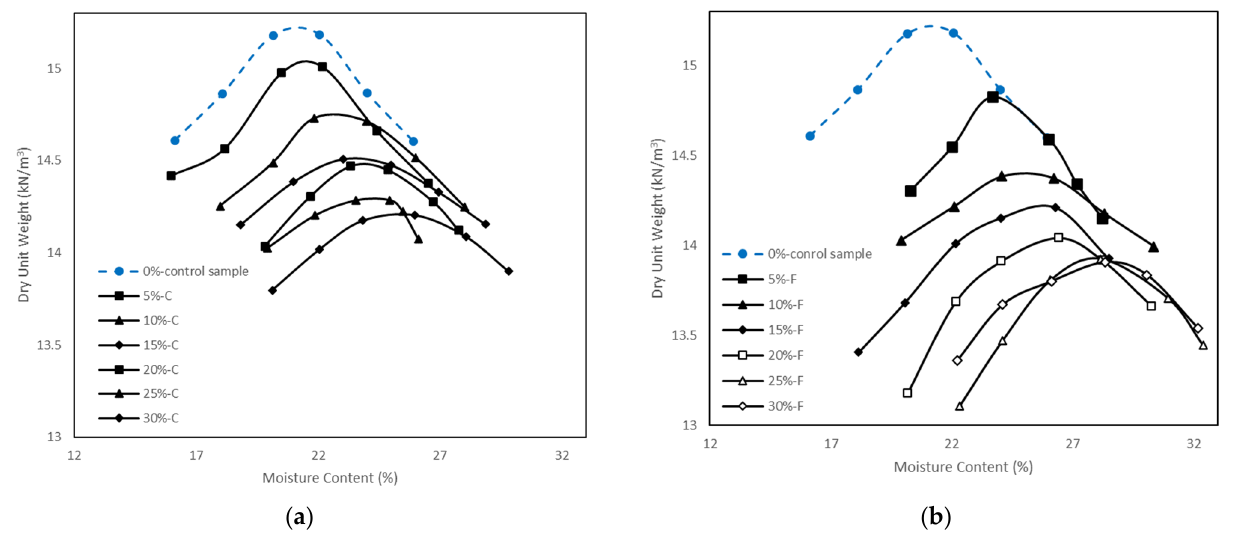
Figure 6. Compaction curves for control sample and soil samples stabilized with ( a ) class C fly ash and ( b ) class F fly ash.